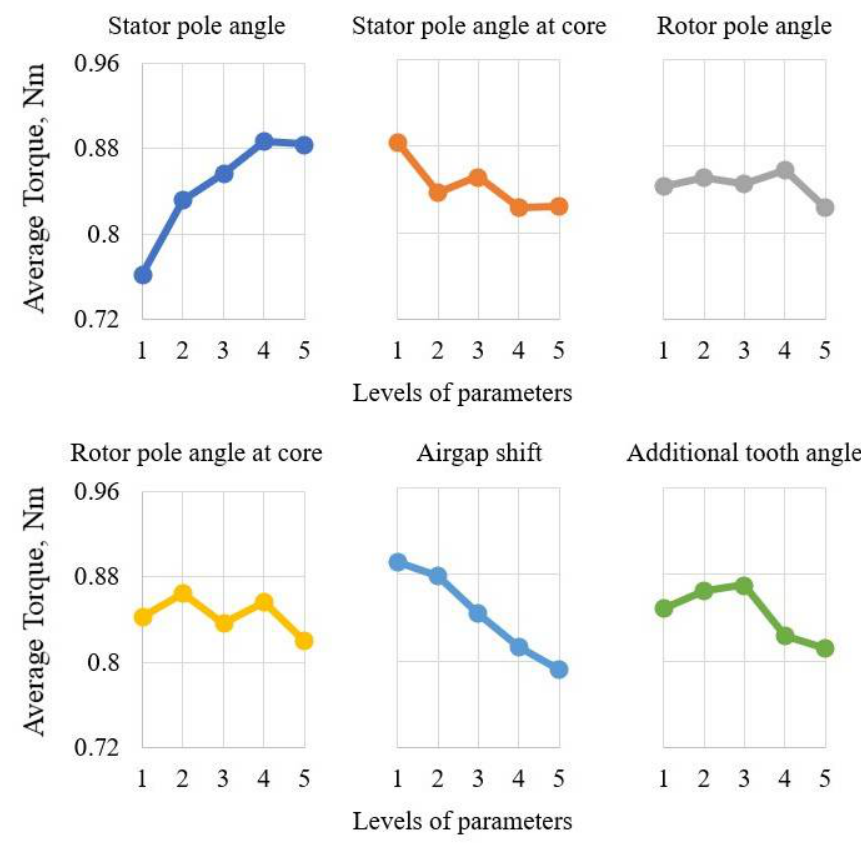
Figure 13. Peak-to-peak values of the average torque. It can be seen in the graphs above (see Figures 13 and 15a) that the stator pole angle and the airgap shift variations have major influences on the average torque. The parameter effect value of the stator pole angle (X 1 ) and airgap shift (X 5 ) are 42% and 28%, respectively. Figure 13 suggests that the growth of the stator pole angle makes the average torque increase rapidly. This fact correlates with Equation (2), which defines θ inc and the duration of torque production as a direct function of the stator pole angle. Meanwhile, the growth in the airgap shift reduces the average torque. One of the reasons could be a torque fall at